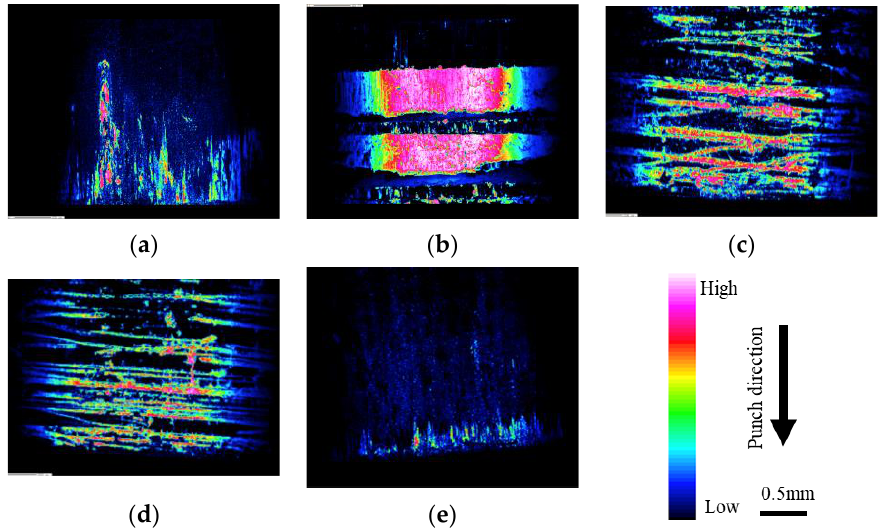
Figure 6. Evaluation of adhesion to punch via EPMA: ( a ) mirror surface; ( b ) millimeter-textured; ( c ) 10 μm -textured; ( d ) 5 μm -textured; and ( e ) nanometer-textured punches.